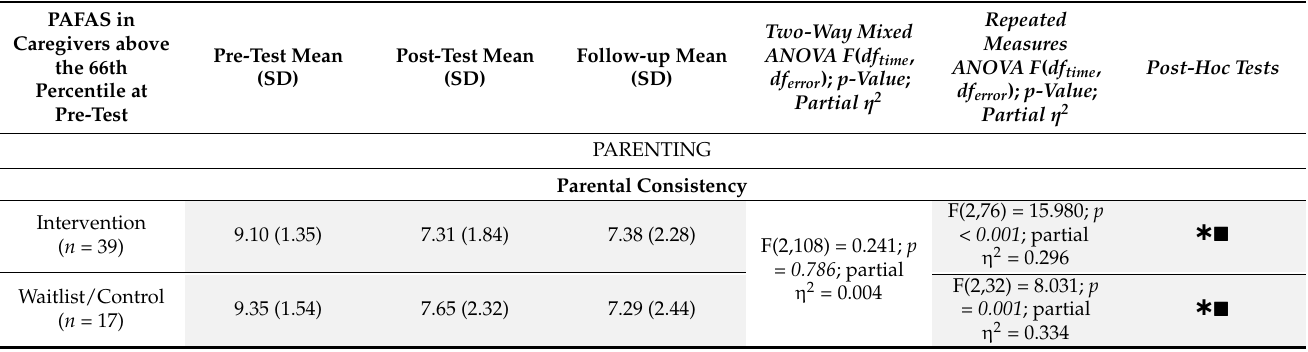
Results for repeated measure ANOVAs and post-hoc tests only shown if significant; SD: standard deviation; ✱ significant difference between t1 and t2, ⦿ significant difference between t2 and t3, ■ significant difference between t1 and t3. Table A4. Mean PAFAS scores over time in caregivers above the 66th percentile at pre-test. ( Higher scores indicating lower levels of Parenting and Family Adjustment skills